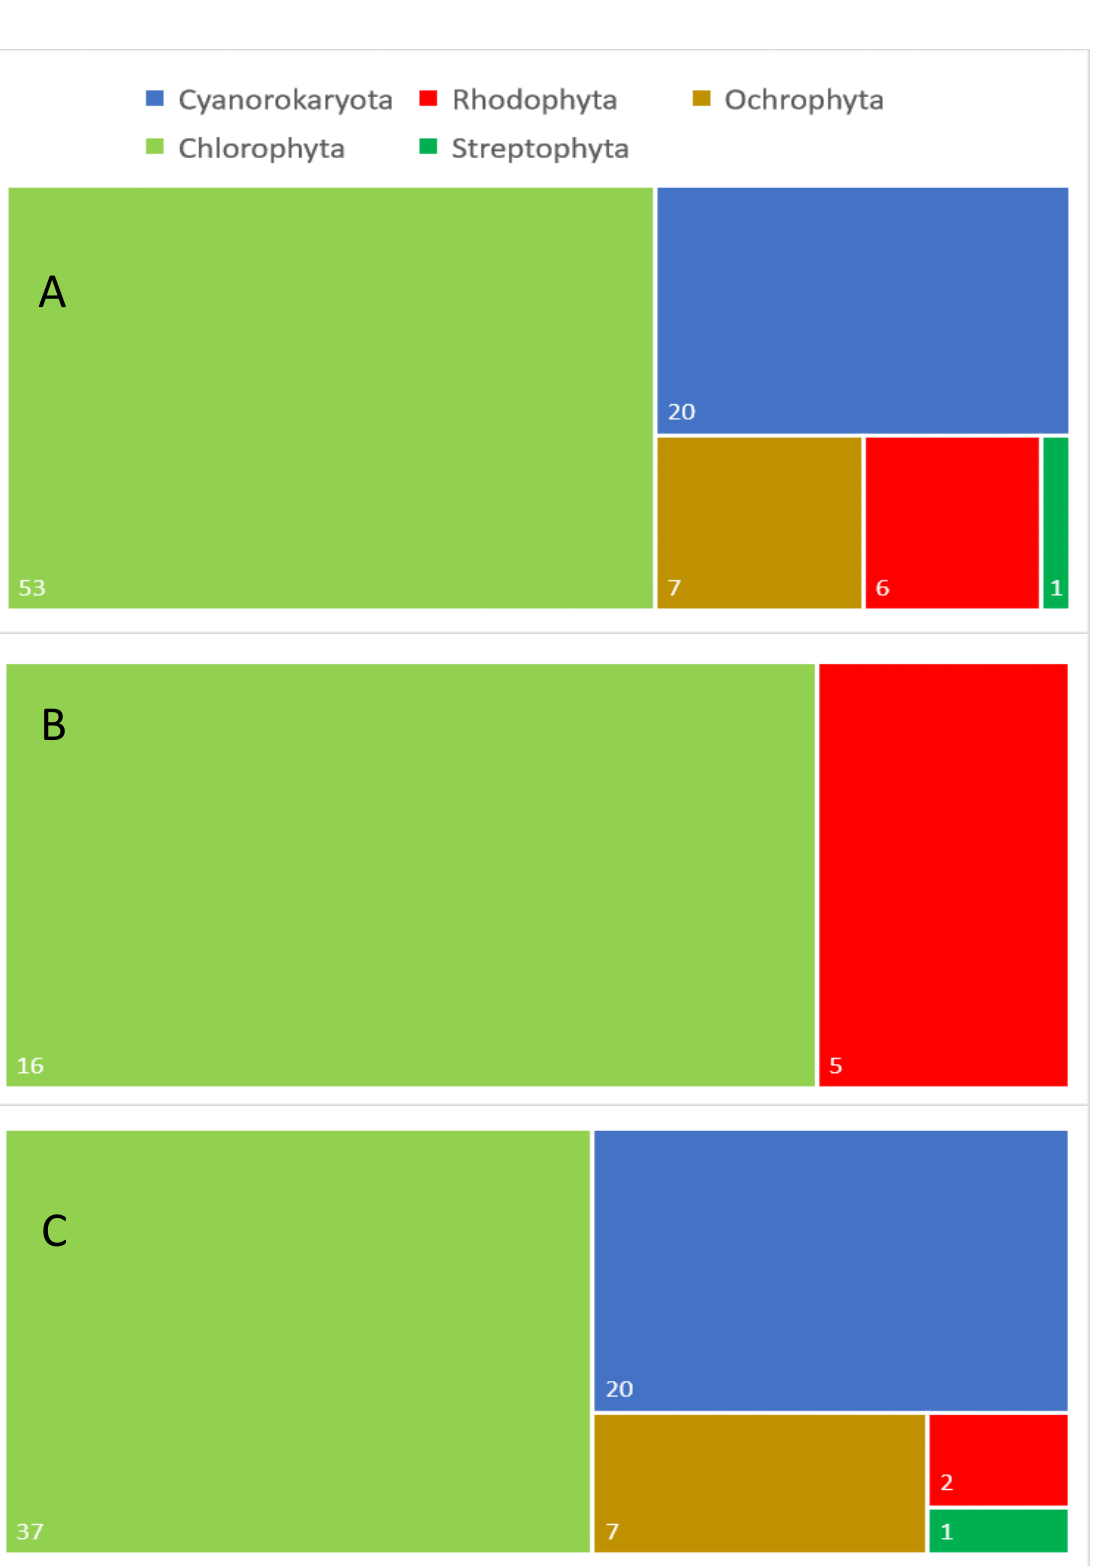
Figure 1. Taxonomic diversity of aeroterrestrial and extremophilic microalgae analyzed for different lipids: ( A ) general taxonomic diversity of the analyzed algal species, ( B ) taxonomic diversity of the examined extremophilic species and ( C ) taxonomic diversity of the investigated aeroterrestrial species. Numbers in white indicate the exact number in each category.